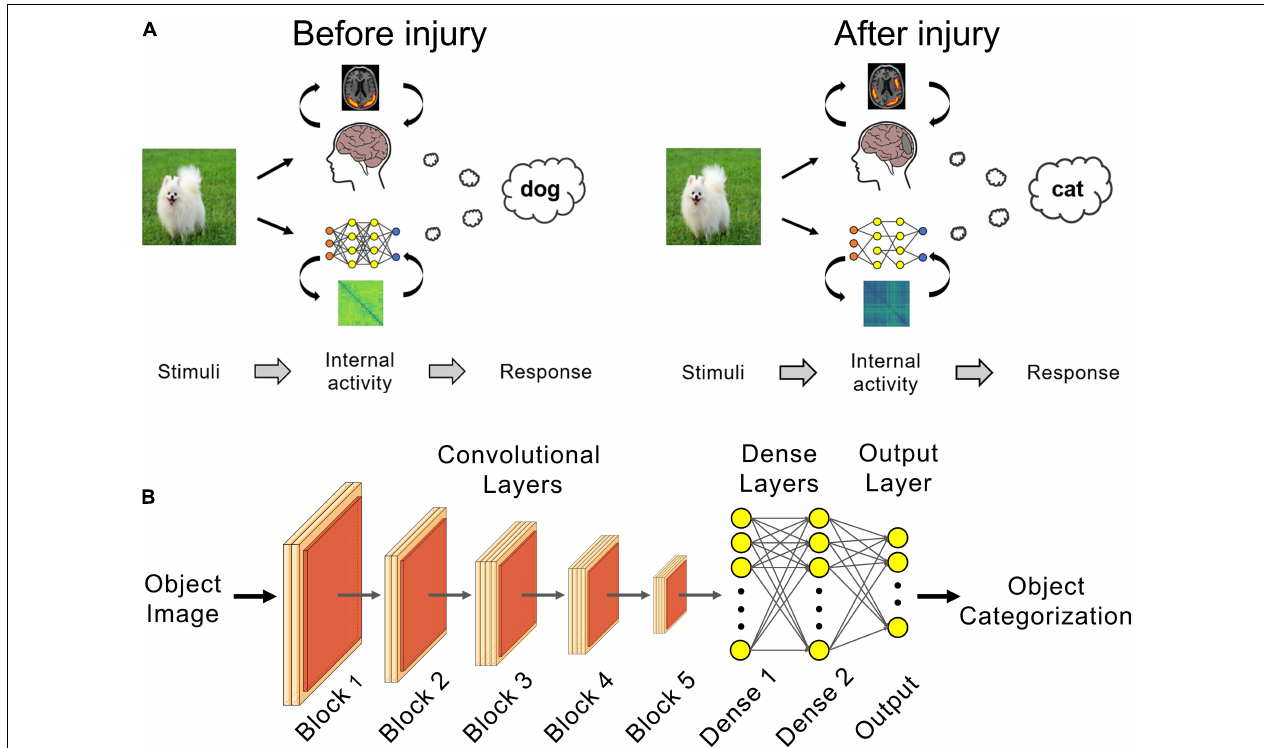
FIGURE 1 | Deep learning can be used as in silico models of brain injury. (A) Changes in internal patterns of activity between neurons and in external behavior can be studied in trained networks before and after a simulated neural injury, such as for posterior cortical atrophy (PCA) as shown here. (B) VGG 19 networks trained for visual object recognition on the CIFAR-100 dataset were used for PCA simulation